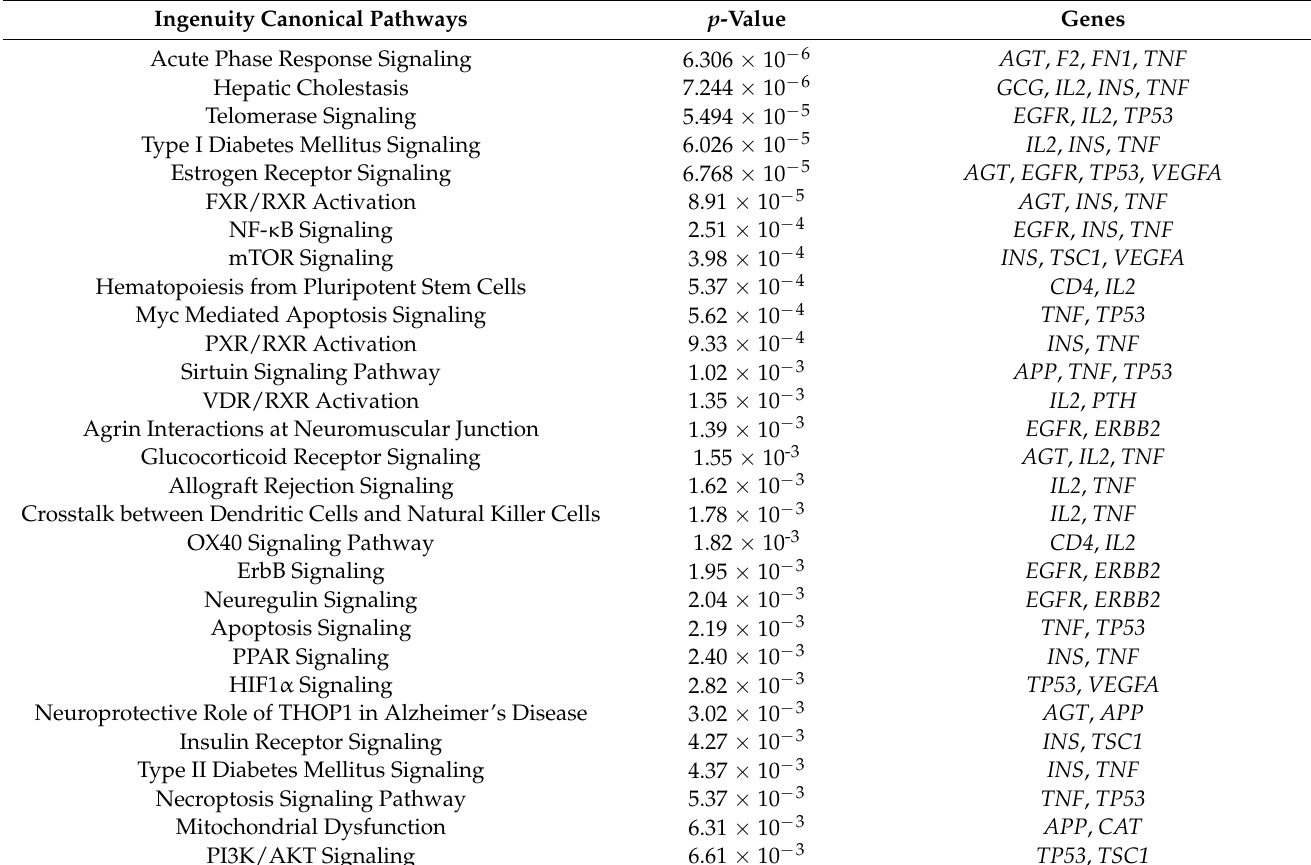
Table 2. Ingenuity pathway analysis showing significant (Fisher’s Exact Test p < 0.05) pathways overrepresented for the 16 genes found via Coremine Medical. Pathways with significant p -values > 0.01 are displayed in Appendix